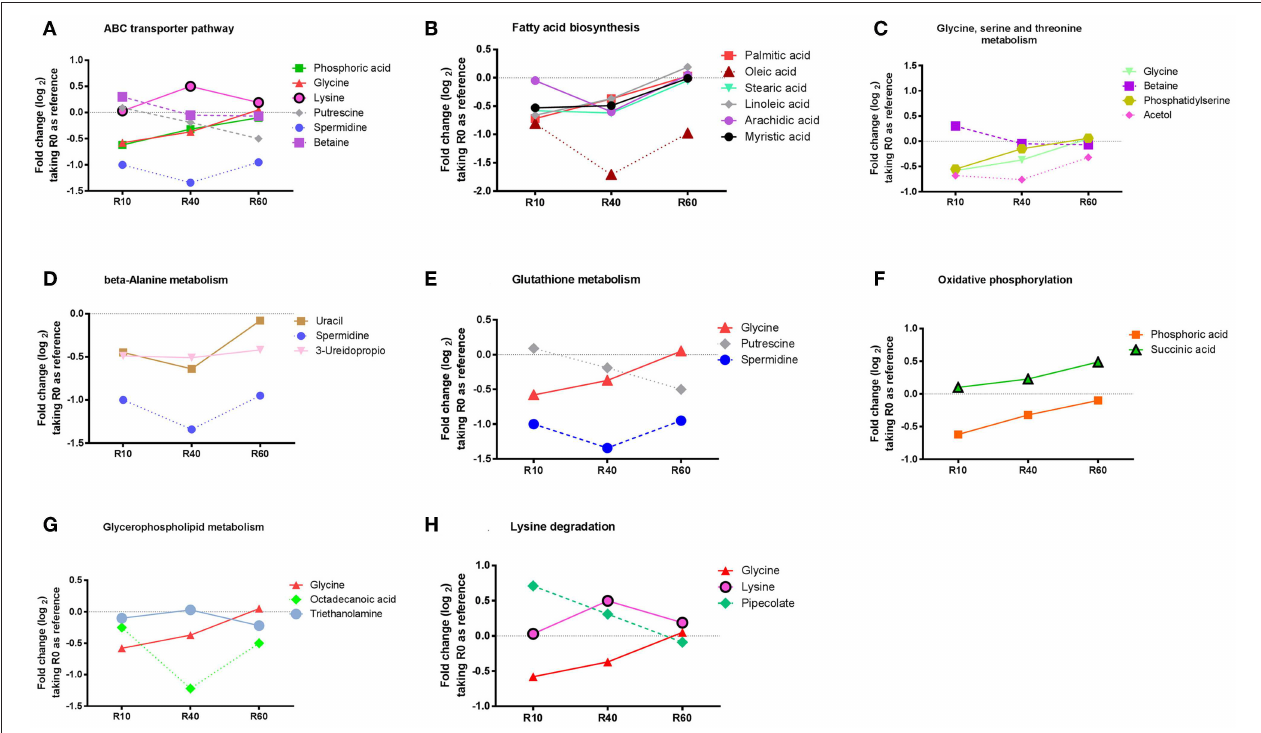
FIGURE 5 | Enriched and non-enriched pathways, identified by MBRole online software, form L. amazonensis metabolites associated with the attenuation process, as detected by the metabolomic fingerprint multiplatform approach. Identified metabolites were submitted to MBRole online software, using their KEGG IDs, with L. major pre-compiled reference, in order to map those biological pathways with statistic significance. Fifty-two metabolites could be identified with KEGG IDs and were mapped in 42 pathways. Eight pathways were mapped as enriched (statistic significant): ABC transporters (A) , Fatty acids Biosynthesis (B) , Glycine, serine and threonine metabolism (C) , B- beta-Alanine metabolism (D) , Glutathione metabolism (E) , Oxidative phosphorylation (F) , Glycerophospholipid metabolism (G) , Lysine degradation (H) . The metabolites responsible for identification of each enriched pathways are represented in graphics, showing Log 2 fold change, expressed as the average ionic abundance in R0xR10, R0xR40, and R0xR60, to obtain a kinetic analysis of metabolites during attenuation by SIVP.